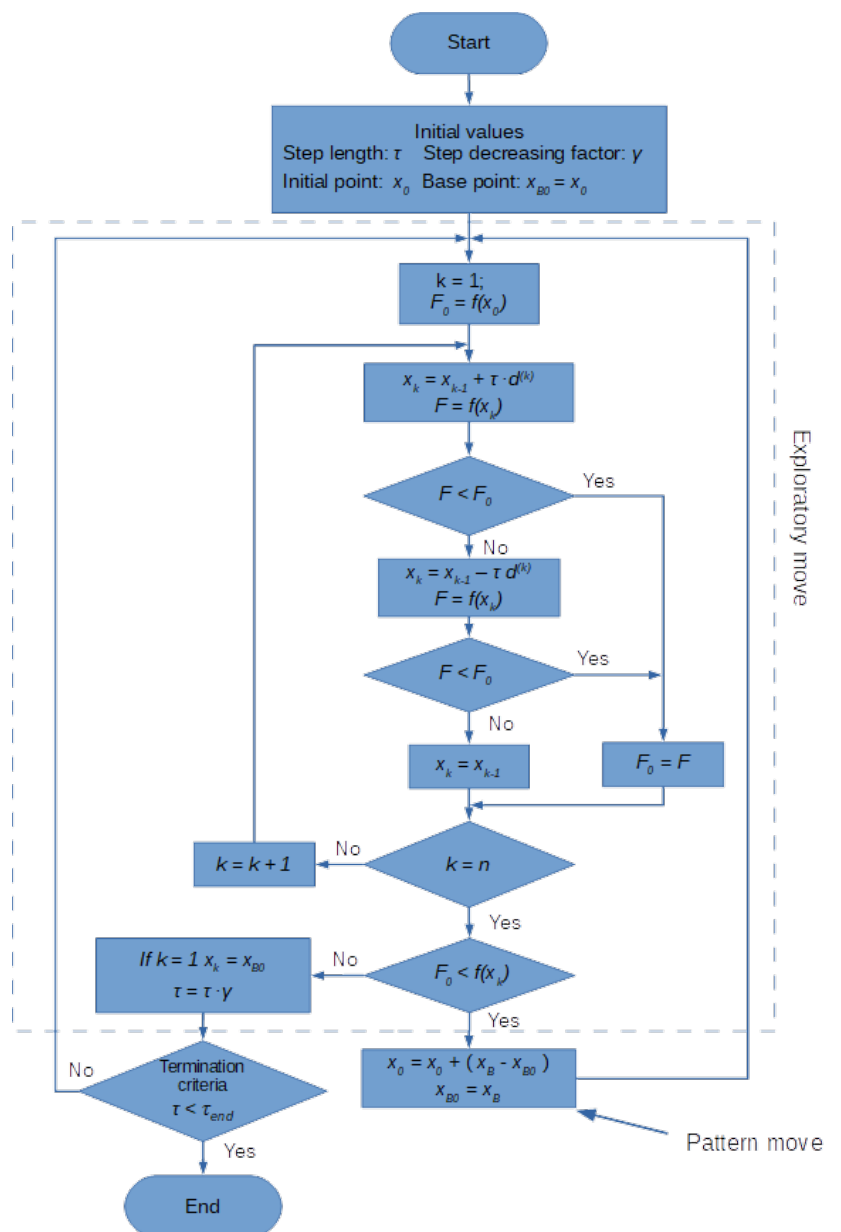
Figure 3. Flowchart of the Hooke-Jeeves method.